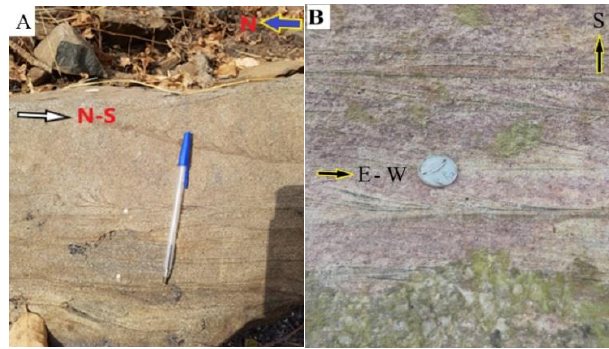
Figure 7: (A) N-S directed cross-beds occurring in the Chagupana sandstones (B) E-W directed cross-beds in the Huni